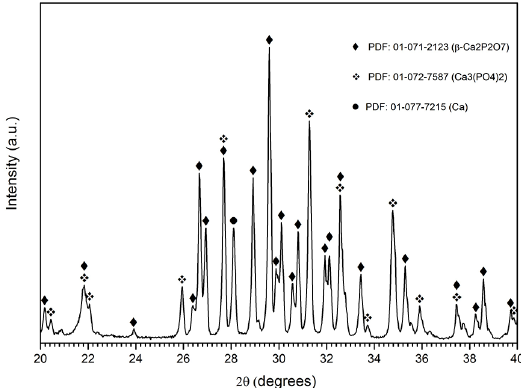
Figure 1. X-ray diffraction pattern of calcium phosphate powder.